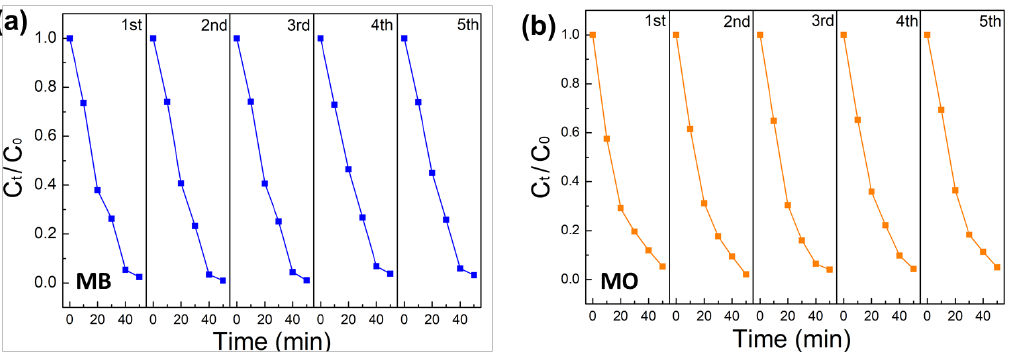
Figure 7. The cyclic stability of ZnO/BNQD-4 for five cycles: ( a ) In MB and ( b ) in